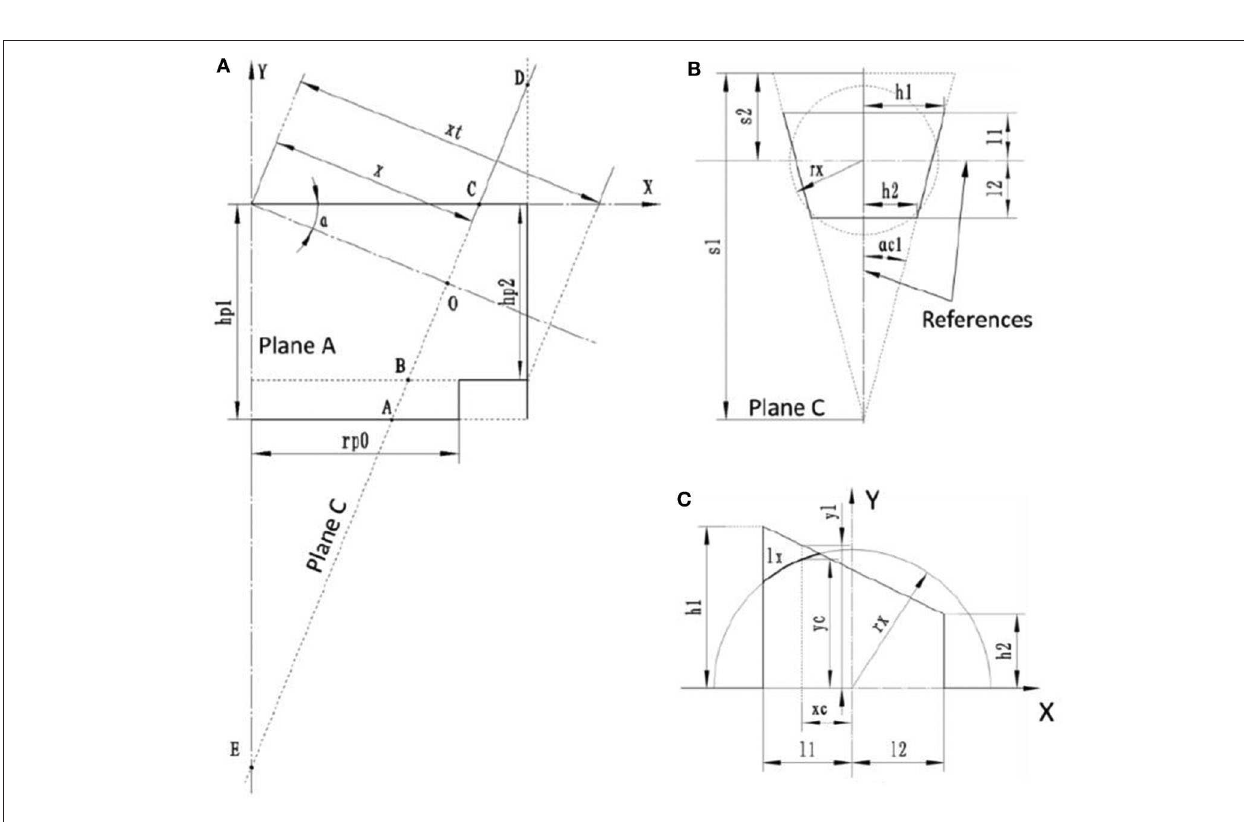
FIGURE 6 | (A) Coordinate system developed for plane A. (B) Geometrical definition of Plane C. (C) Coordinate system developed for Plane C.